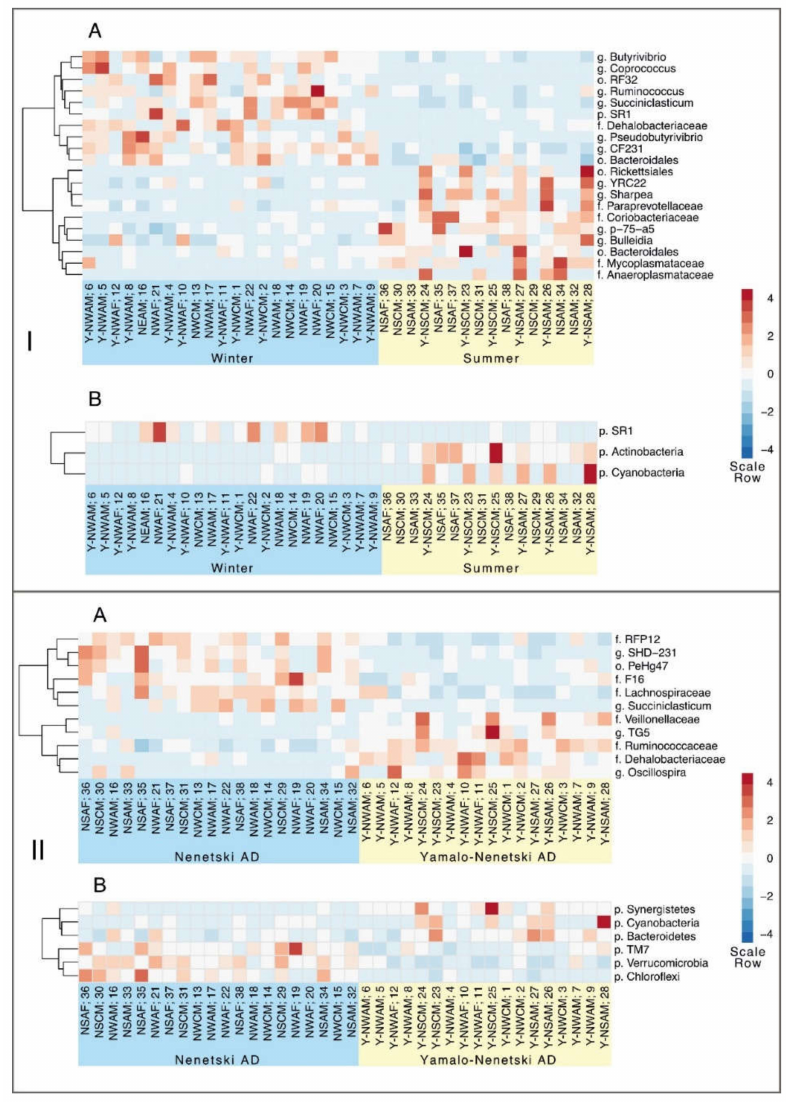
Figure 7. Heat map analysis of the taxa dominating the ruminal microbiome of reindeer from Russian Arctic zones in different seasons ( I ) and regions ( II ) at the levels of phylum ( A ) and genus ( B ). Regions: N—Nenetski Autonomous District (AD); Y-N—Yamalo-Nenetski AD. Seasons: S—summer; W—winter. Age: A—adults; C—calves. Sex: M—male; F—female. The analysis at the genus level revealed significant seasonal differences in bacteria from the family Coriobactriaceae (0.28 ± 0.05 in summer vs. 0.008 ± 0.006 in winter, p < 0.001). The concentration of members of the family Erysipelothrihaceae (1.0 ± 0.12 in summer vs. 0.5 ± 0.04 in winter, p < 0.001), including the genera Sharpea spp. (0.06 ± 0.02 in summer vs. 0 ± 0 in winter, p = 0.007) and Bulleidia spp. (0.34 ± 0.06 in summer vs. 0.13 ± 0.04 in winter, p = 0.02), and the family Mycoplasmataceae (0.20 ± 0.05 in summer vs. 0.06 ± 0.02 in winter, p = 0.03) were also significantly higher in summer. In winter, the concentrations of members of the family Dehalobacteriaceae (0.02 ± 0.01 in summer vs. 0.16 ± 0.04 in winter, p = 0.001), certain genera from the family Lachnospiraceae ( Butyrivibrio spp. 0.86 ± 0.13 in summer vs. 3.18 ± 0.39 in winter, p < 0.001; Coprococcus spp. 0.14 ± 0.03 in summer vs. 1.07 ± 0.19 in winter, p = 0.003; and Pseudobutyrivibrio spp. 0.004 ± 0.003 in summer vs. 0.12 ± 0.03 in winter, p = 0.02), genus Succiniclacticum from the family Veillionelaceae (1.05 ± 0.24 in summer vs. 5.68 ± 0.85 in winter, p <